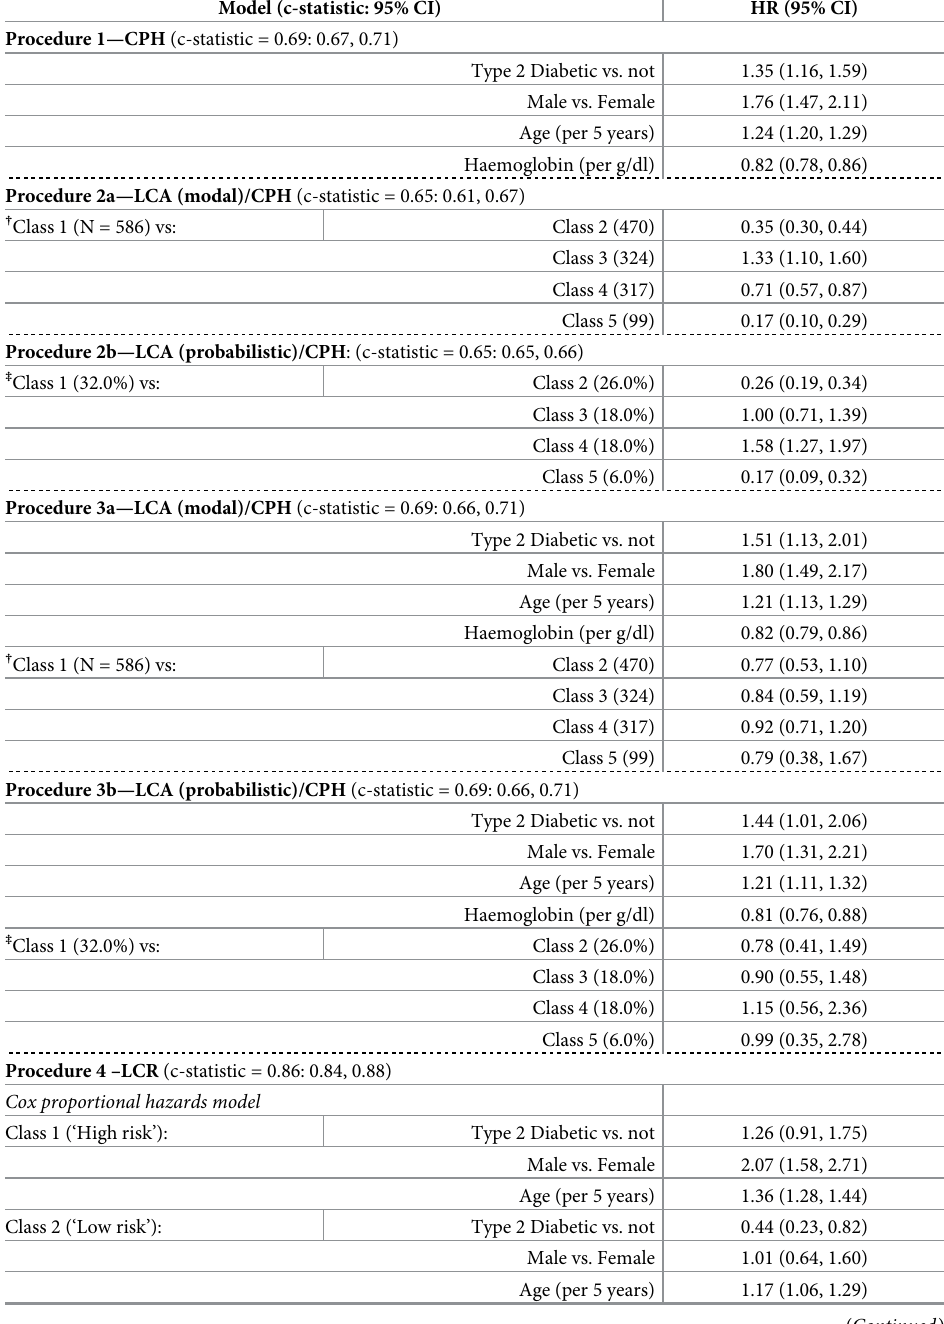
Table 3. Covariate coefficients for each preferred model (Procedures 1–4) executed on the complete data, along with median c-statistic and empirical 95% empirical confidence intervals generated through 10-fold cross-